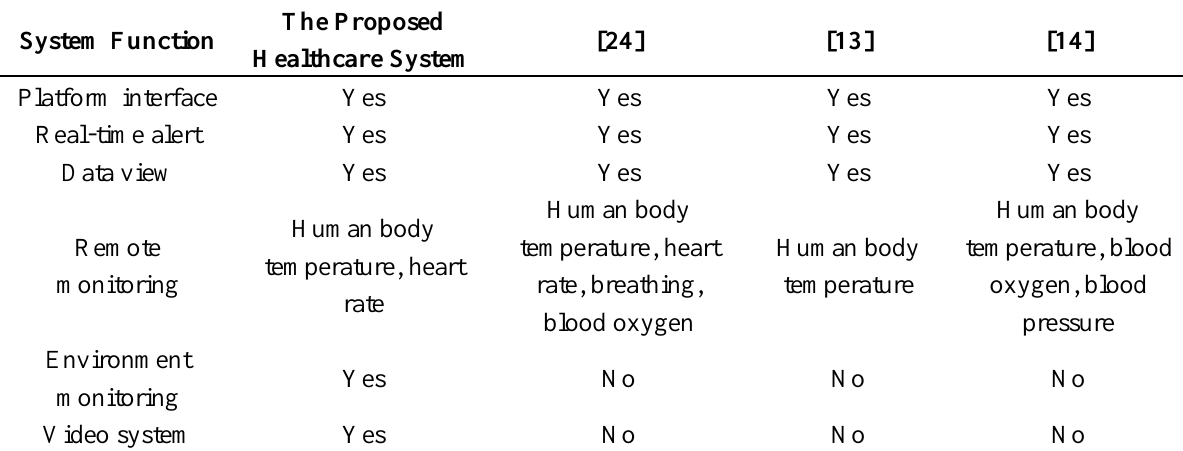
Table 2. Analysis of system